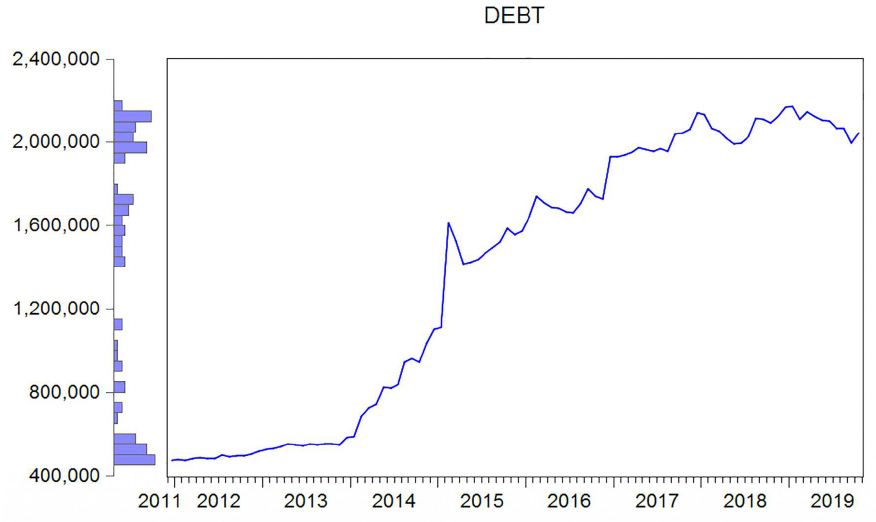
Figure 1. The schedule of the time series of the Ukraine’s